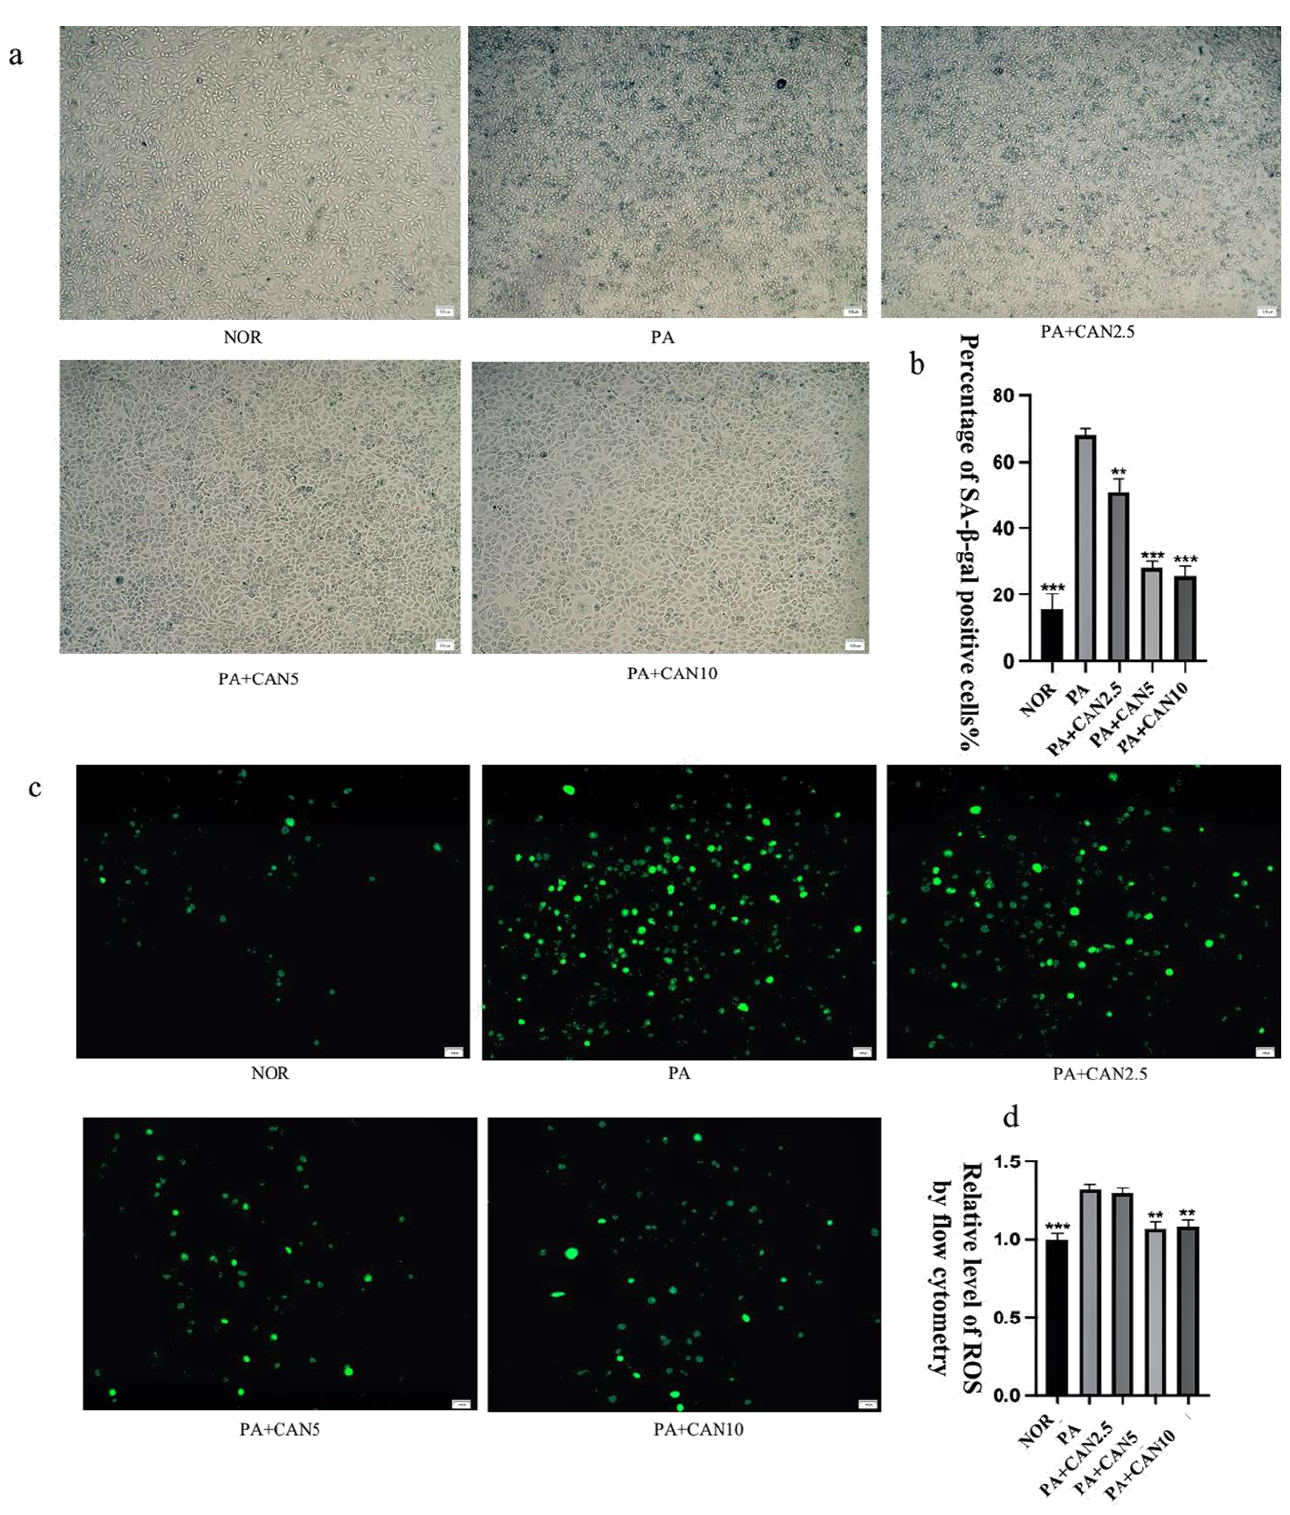
Figure 3. Canagliflozin delays PA-induced aging of HUVECs. ( a , b ) CAN reduced the number of β -galactosidase staining-positive cells in a concentration-dependent manner (2.5 µ g/mL, 5 µ g/mL, 10 µ g/mL). ( c , d ) CAN reduced the abnormal elevation of intracellular ROS due to senescence and the outcome was concentration-dependent (2.5 µ g/mL, 5 µ g/mL, 10 µ g/mL). ( d ) Results of ROS quantification using flow cytometry. Data are expressed as the means ± SD ( n = 3); ** p < 0.01, *** p < 0.001 vs. PA. All images are magnified to 100 ×